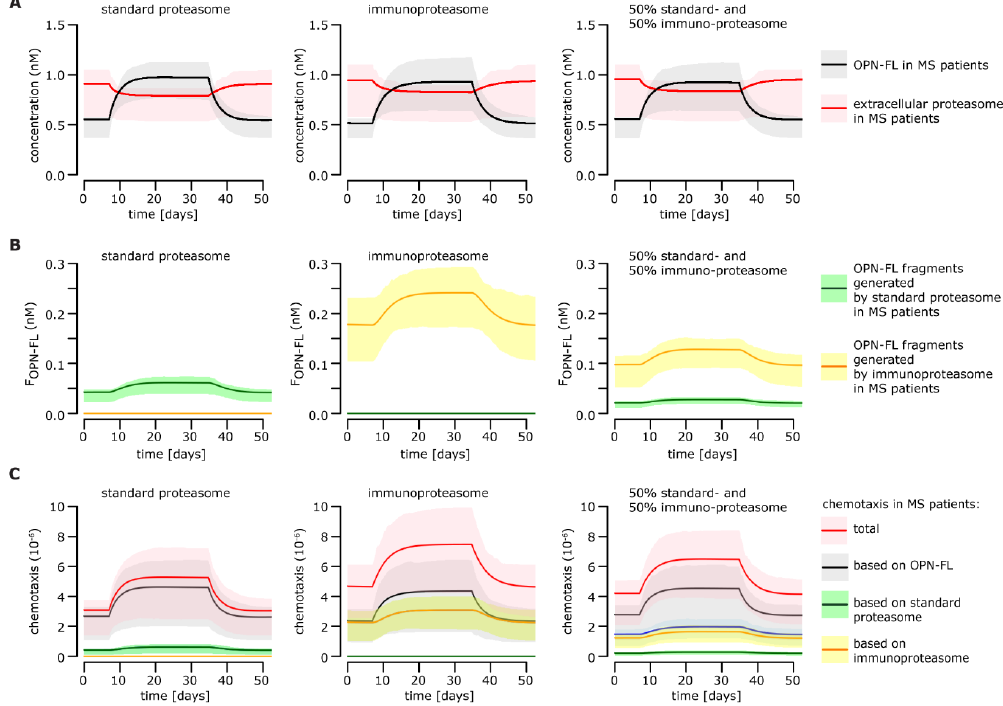
Figure 4. Effect of proteasomes on chemotaxis during RRMS relapse and remission. All simulations are done for standard proteasomes only (left column), immunoproteasomes only (middle column), and 50% standard- and immuno-proteasomes (right column). ( A ) Simulation of OPN-FL and extracellular proteasome concentrations over time in MS patient serum. The behavior of OPN-FL concentration during relapse is given, and the behavior of extracellular proteasome concentration is a result of the modeled system. Here, we assume that only OPN-FL is present in the extracellular space. ( B ) Simulation of the time course of proteasome-generated OPN fragments in MS patient serum. ( C ) Level of chemotaxis over the course of the disease in MS patients. The chemotaxis is computed based on the cell migration experiments performed with HUVECs (Figure 3). Additionally, to the overall expected chemotaxis levels, the chemotaxis based only on OPN-FL, only on standard proteasomes, and only on immunoproteasomes is shown, respectively.